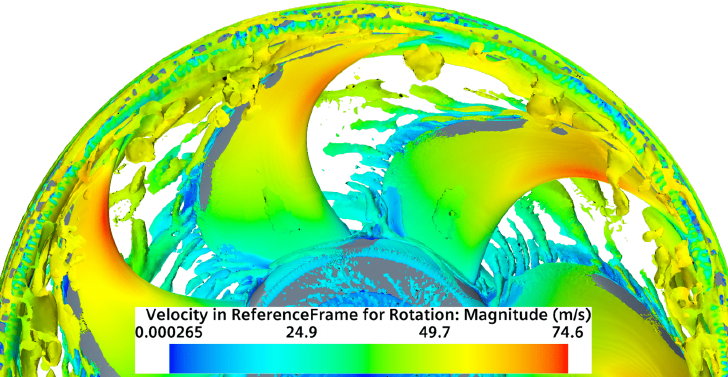
Figure 1. The relative velocity is plotted for an unsteady DES computation onto the isosurface obtained with the Q-criterion technique; large vortical structures are depicted in particular close to the ring and in the trailing-edge recirculating region near the hub.